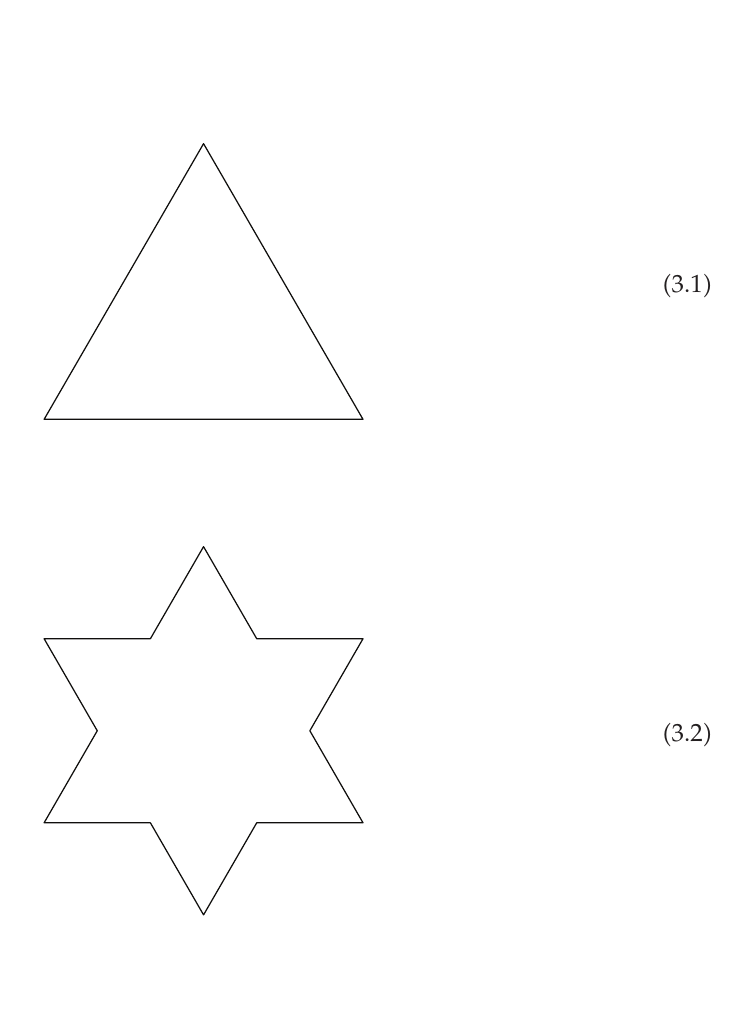
Figure 7: Half a hairy half-plane, f (cid:5) z (cid:6) (cid:4)